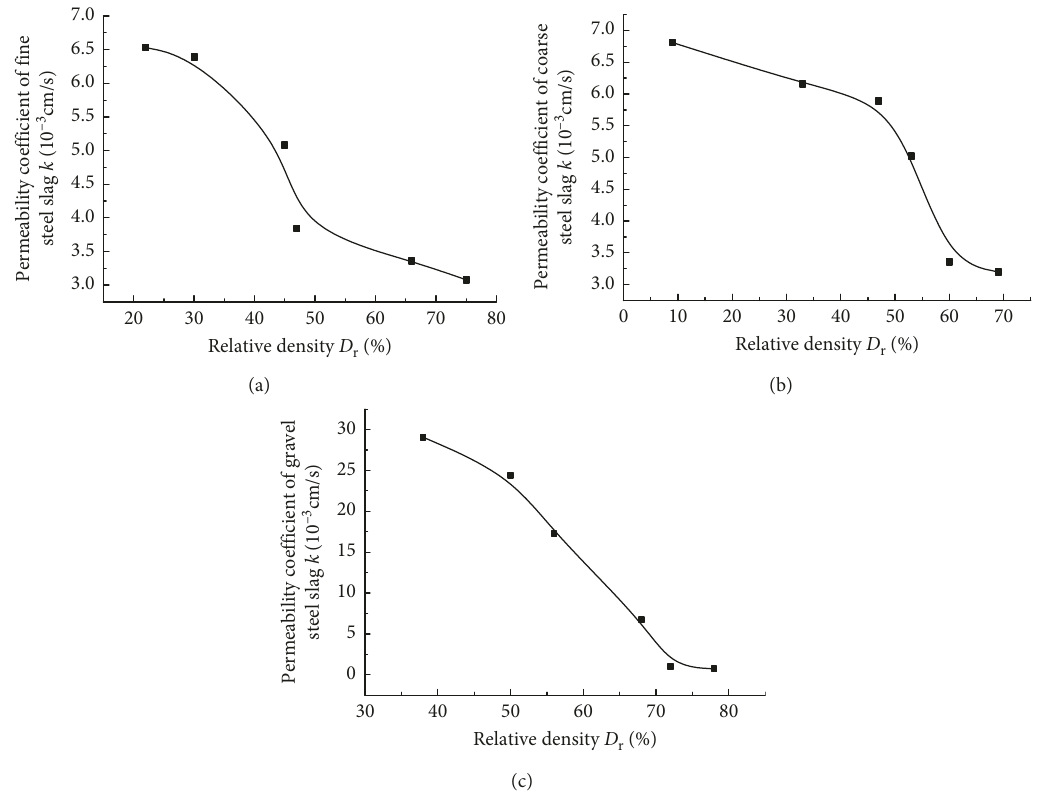
Figure 5: Curves on the permeability coefficients of three types of steel slag with changing relative density: (a) fine steel slag; (b) coarse steel slag; (c) gravel steel